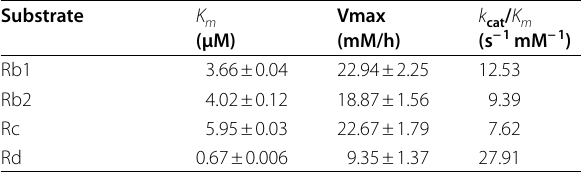
Table 4 Kinetic parameters for BcelFp with